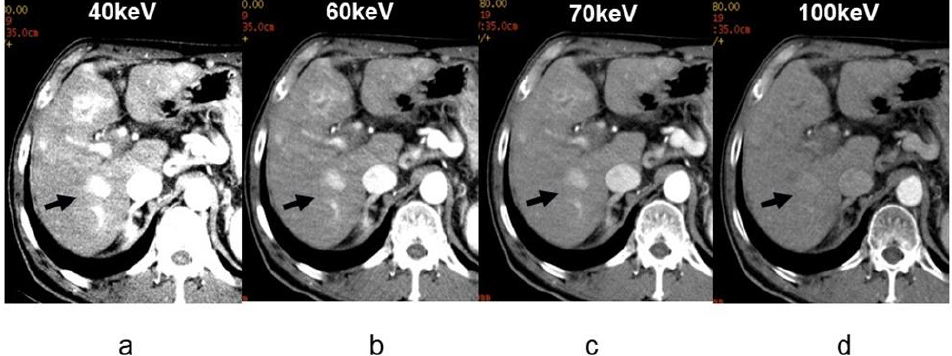
Figure 4. Contrast enhancement of virtual monochromatic images in the same patient. A dynamic CT arterial phase at ( a ) 40, ( b ) 60, ( c ) 70, and ( d ) 100 keV. The 120 kVp CT used in conventional CT is approximately equivalent to the 70 keV image. The difference in contrast enhancement in the deep staining (arrow) of the hepatocellular carcinoma induced by the differences in keV is clear. The contrast enhancement at low-keV values is high but noisy, while the enhancement at high keV such as 100 KeV is clearly poor.